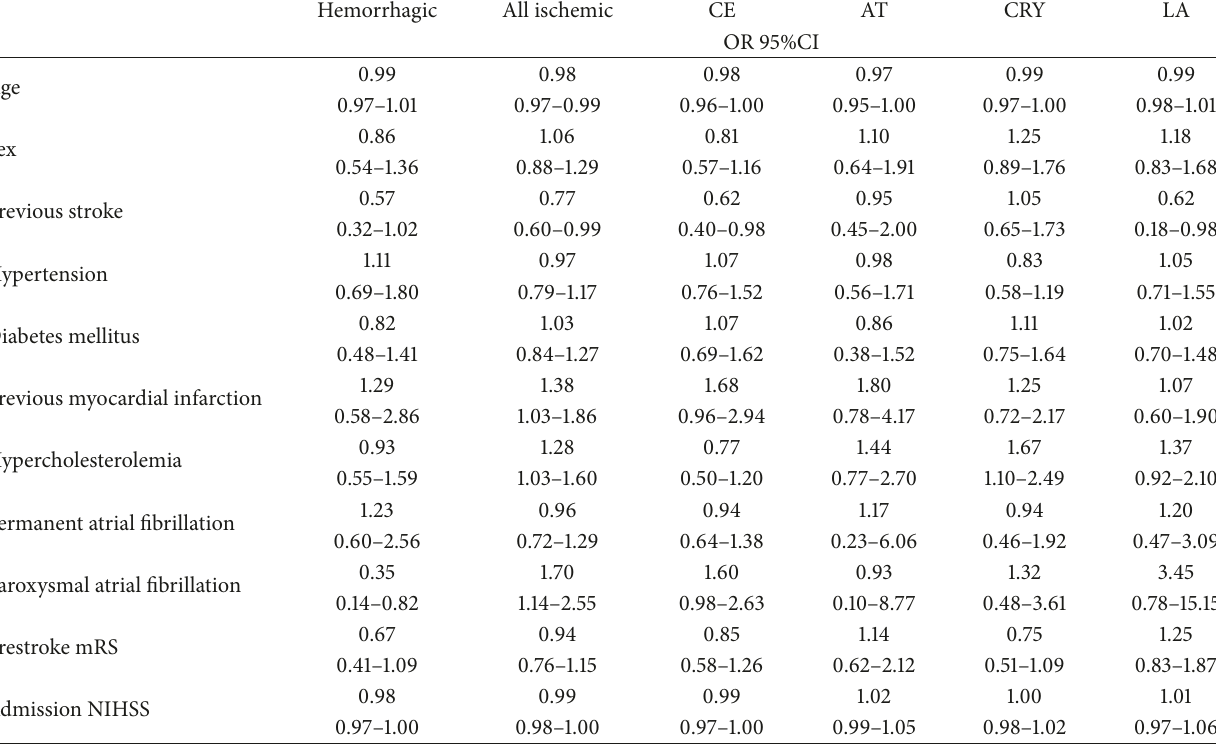
Table 3: Multivariate logistic regression between clinical variables (independent variables) and awake/asleep stroke onset (dependent variable).